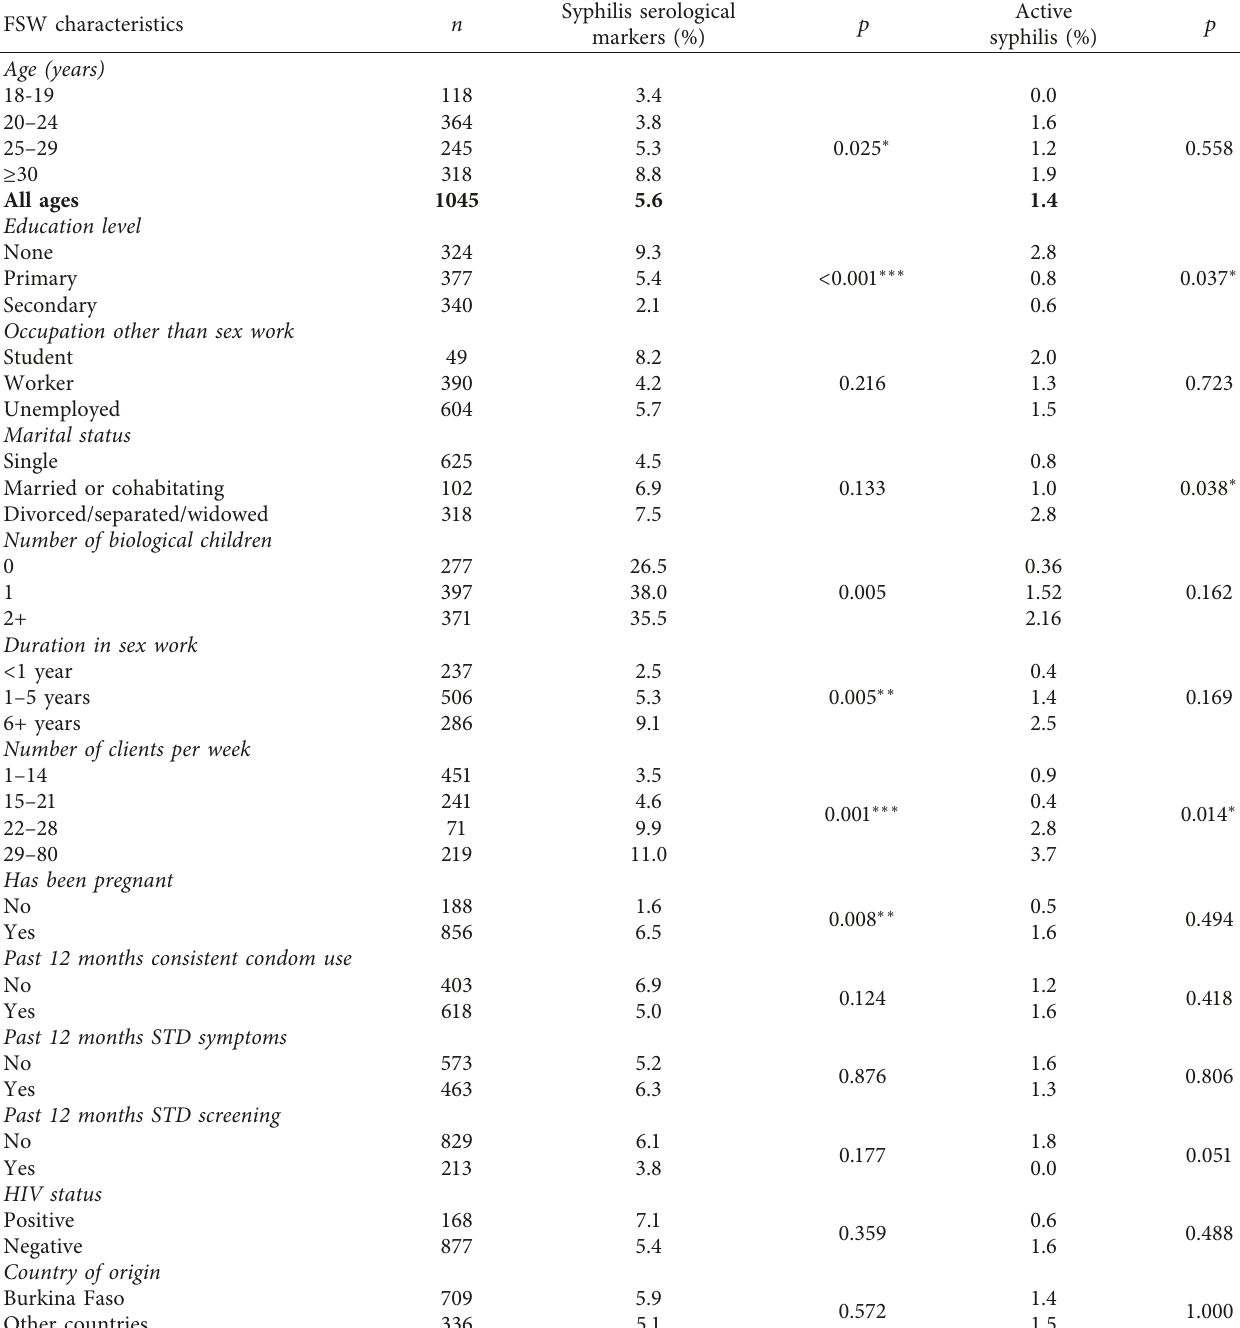
Table 3: Prevalence of syphilis serological markers and of active syphilis among female sex workers in Burkina Faso. FSW